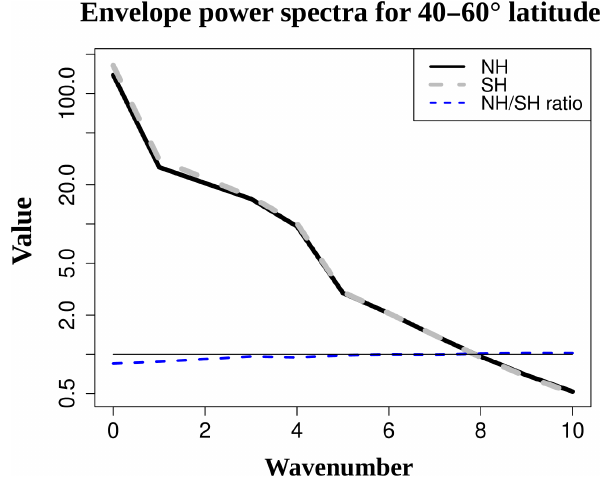
Figure 12. Average zonal wavenumber power spectra of RWP en- velopes between 40 and 60 ◦ latitude for NH (black) and SH (grey). The blue line denotes the NH / SH ratio, with the thin black line showing a 1 : 1 ratio. As in Figs. 6 and 8, RWP envelopes are calcu- lated at zonal-mean tropopause